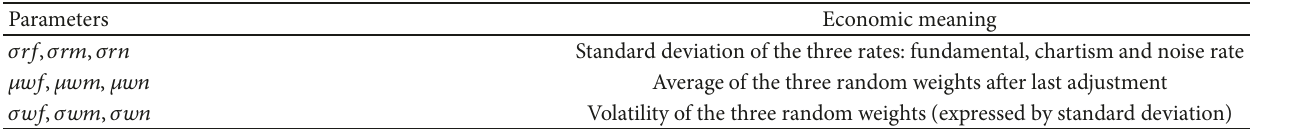
Table 3: Bayesian parameters.